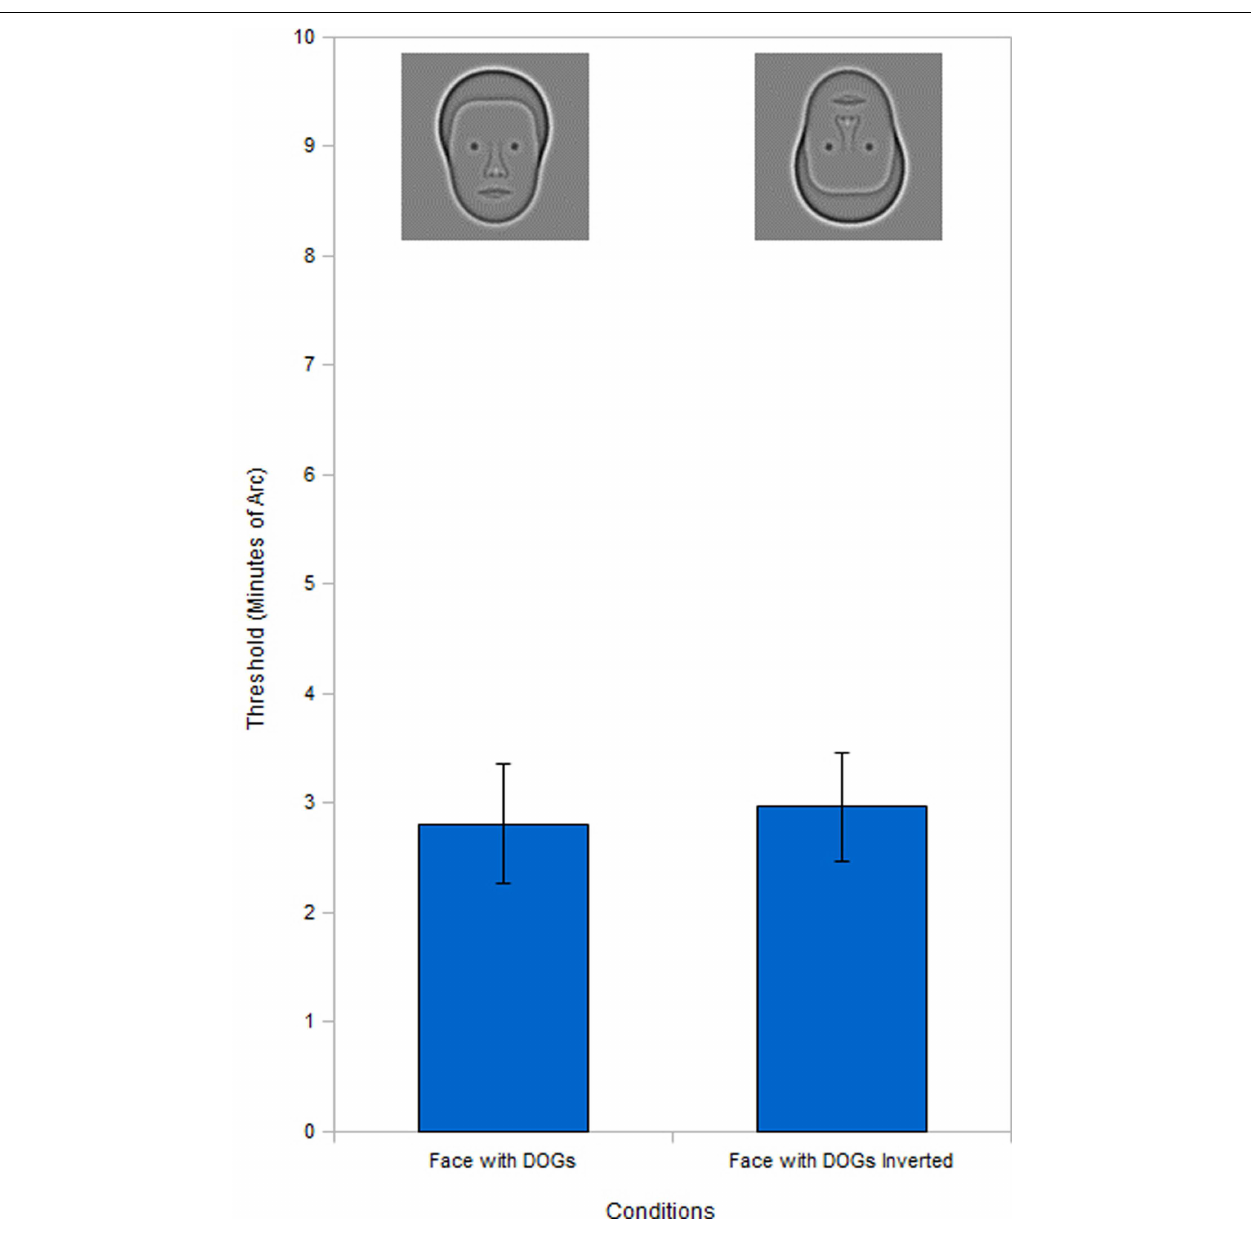
FIGURE 7 | Full face inversion. Inversion test of the face with DOGs condition shows no significant inversion